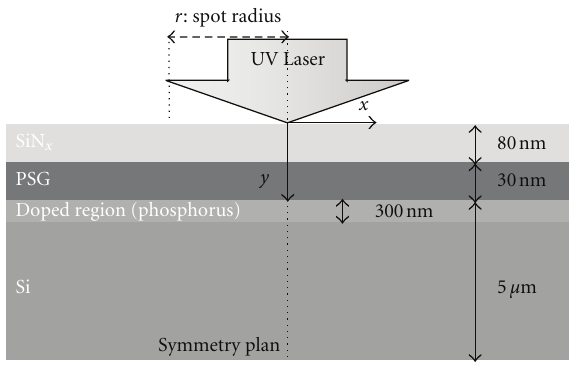
Figure 2: Sample geometry.